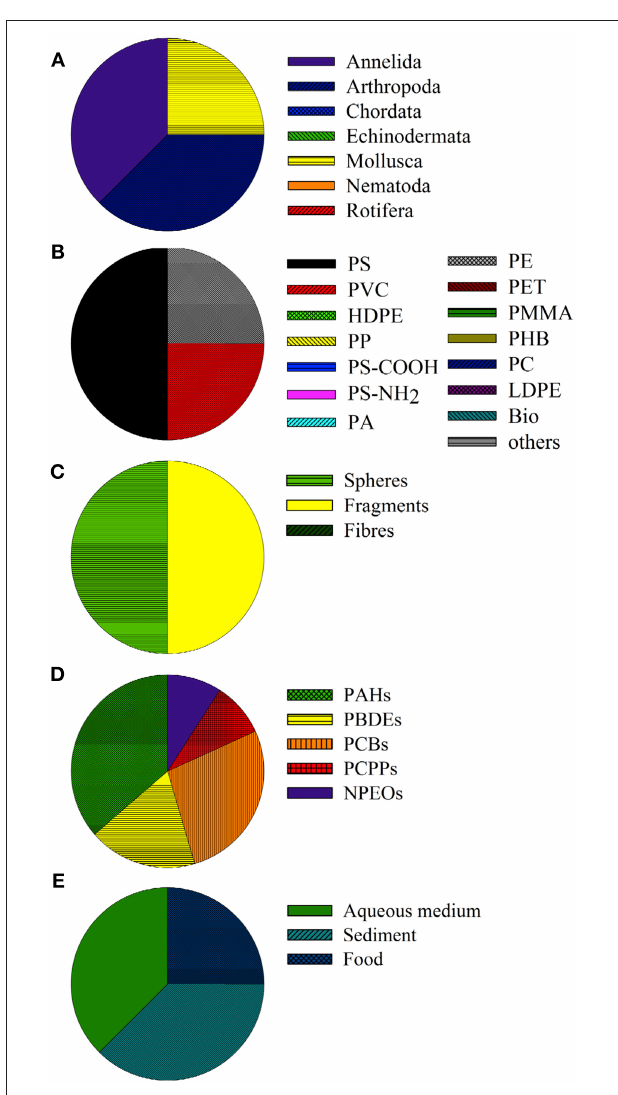
FIGURE 4 | Toxicity assays examining chemical effects posed by the interaction of chemicals and plastic particles in marine benthic invertebrates. Data depict the groups of organisms (taxa) used (A) , polymer types (B) , shape of particles applied (C) , POPs used as co-contaminant (D) , and matrix or route of exposure (E)